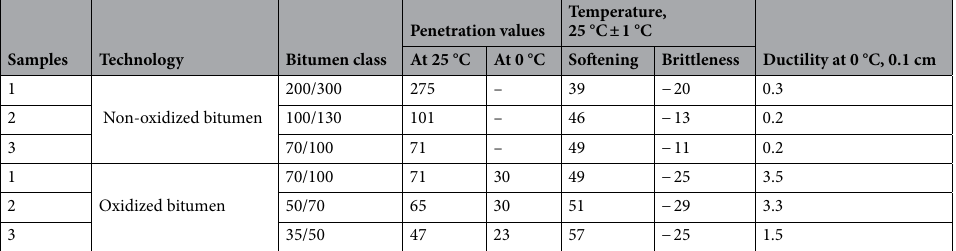
Table 5. Results of the properties of the obtained non-oxidized and oxidized bitumen.